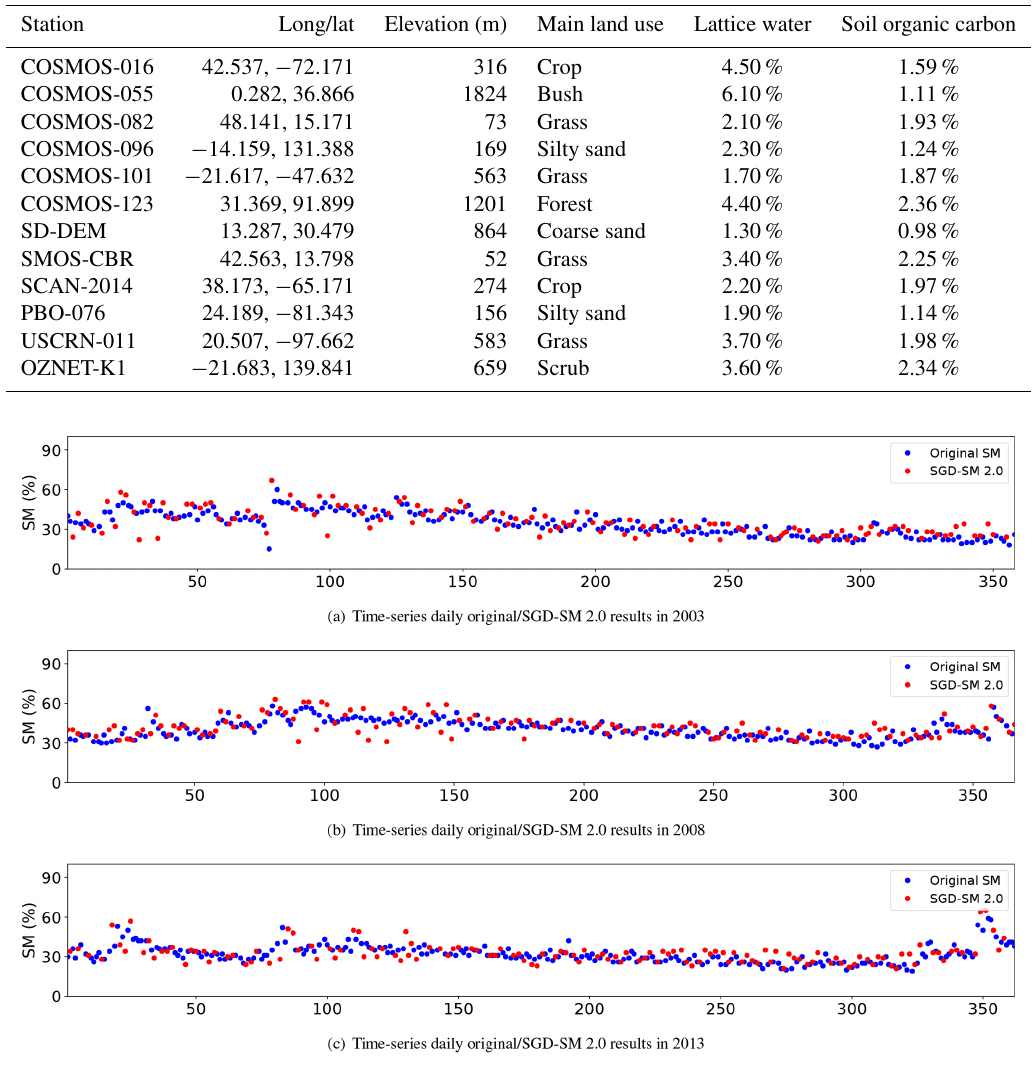
Table 3. Basic information about the in situ soil moisture sites (taking partial sites as examples).